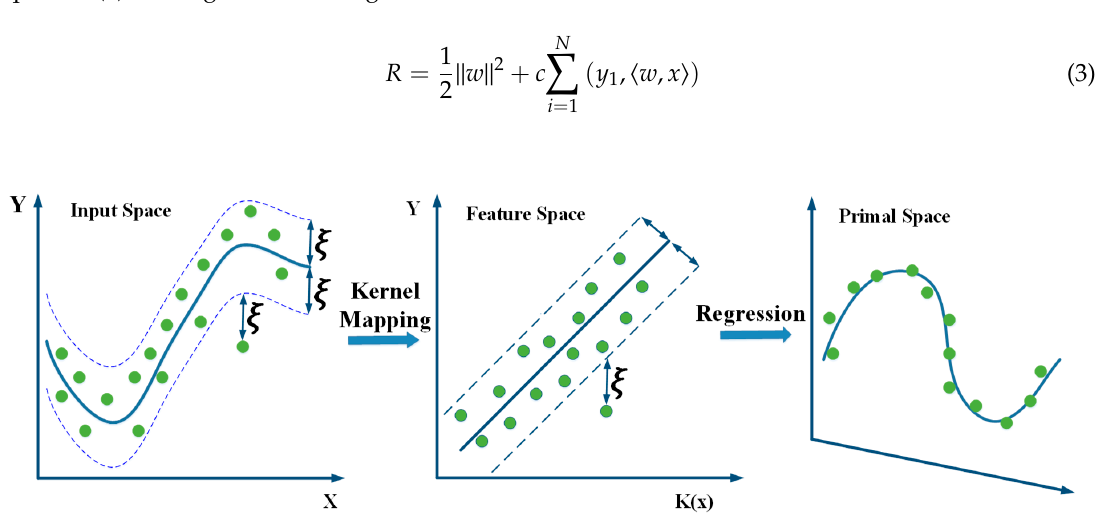
Figure 2. The principle of support vector regression (SVR).